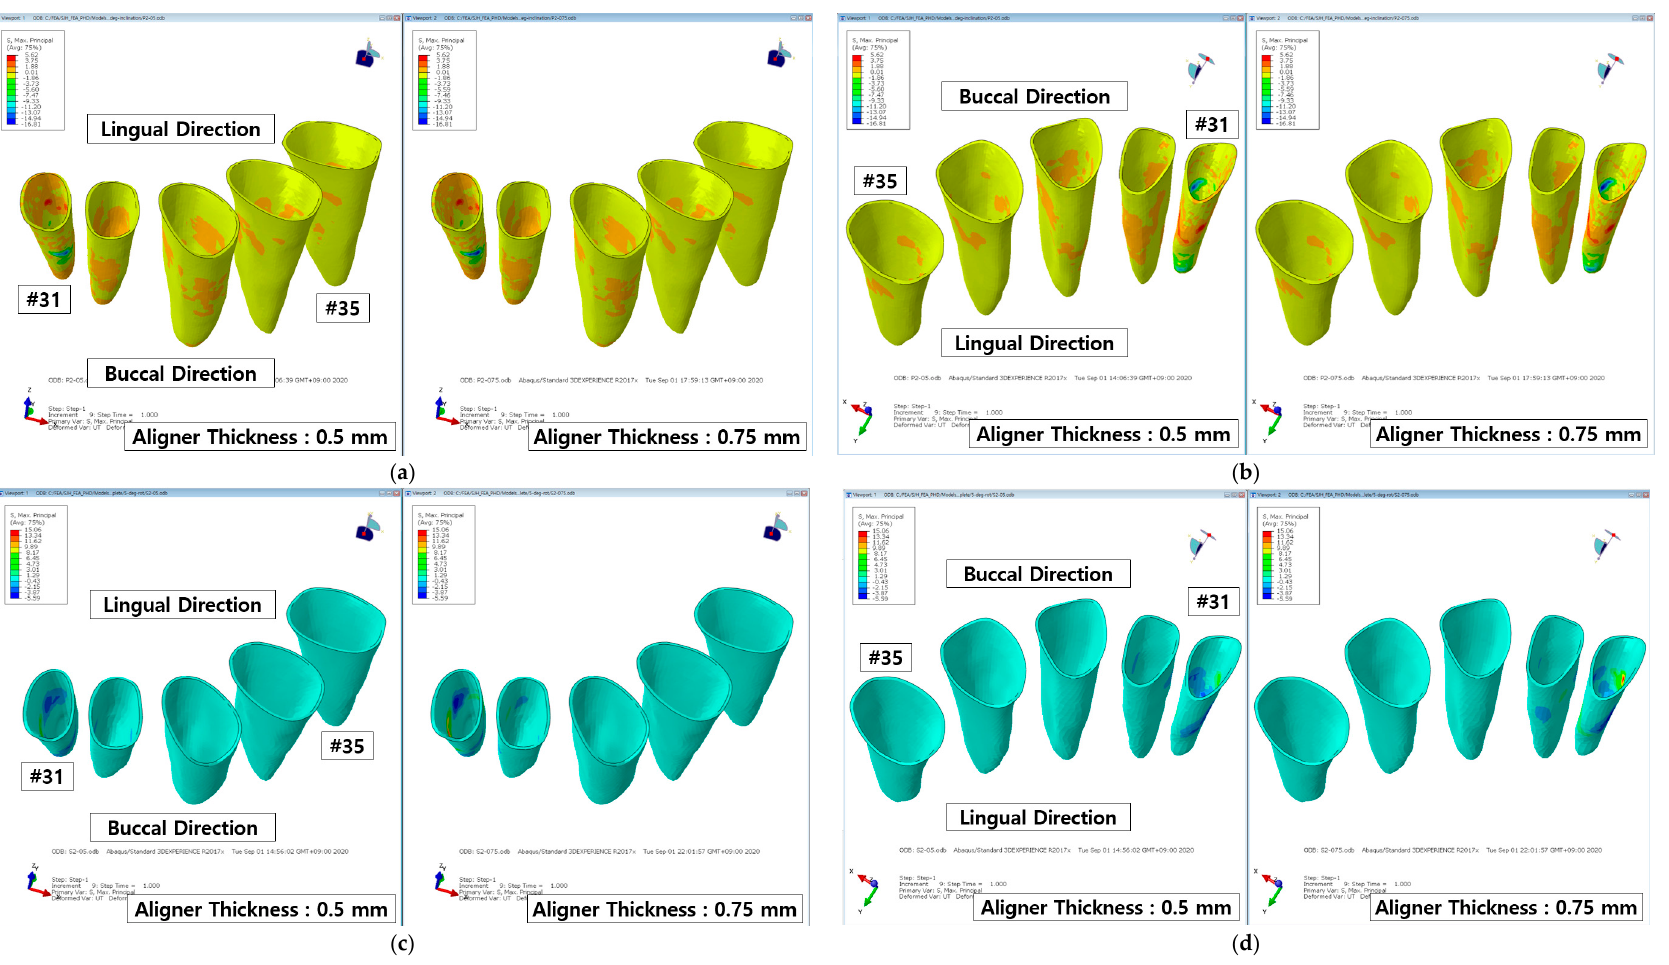
Figure 7. Principal stress distributions in the PDLs following transparent aligner orthodontic treatment of the central incisor. ( a ) buccal- and ( b ) lingual-direction view after lingual inclination correction; ( c ) buccal- and ( d ) lingual-direction view after axial rotation